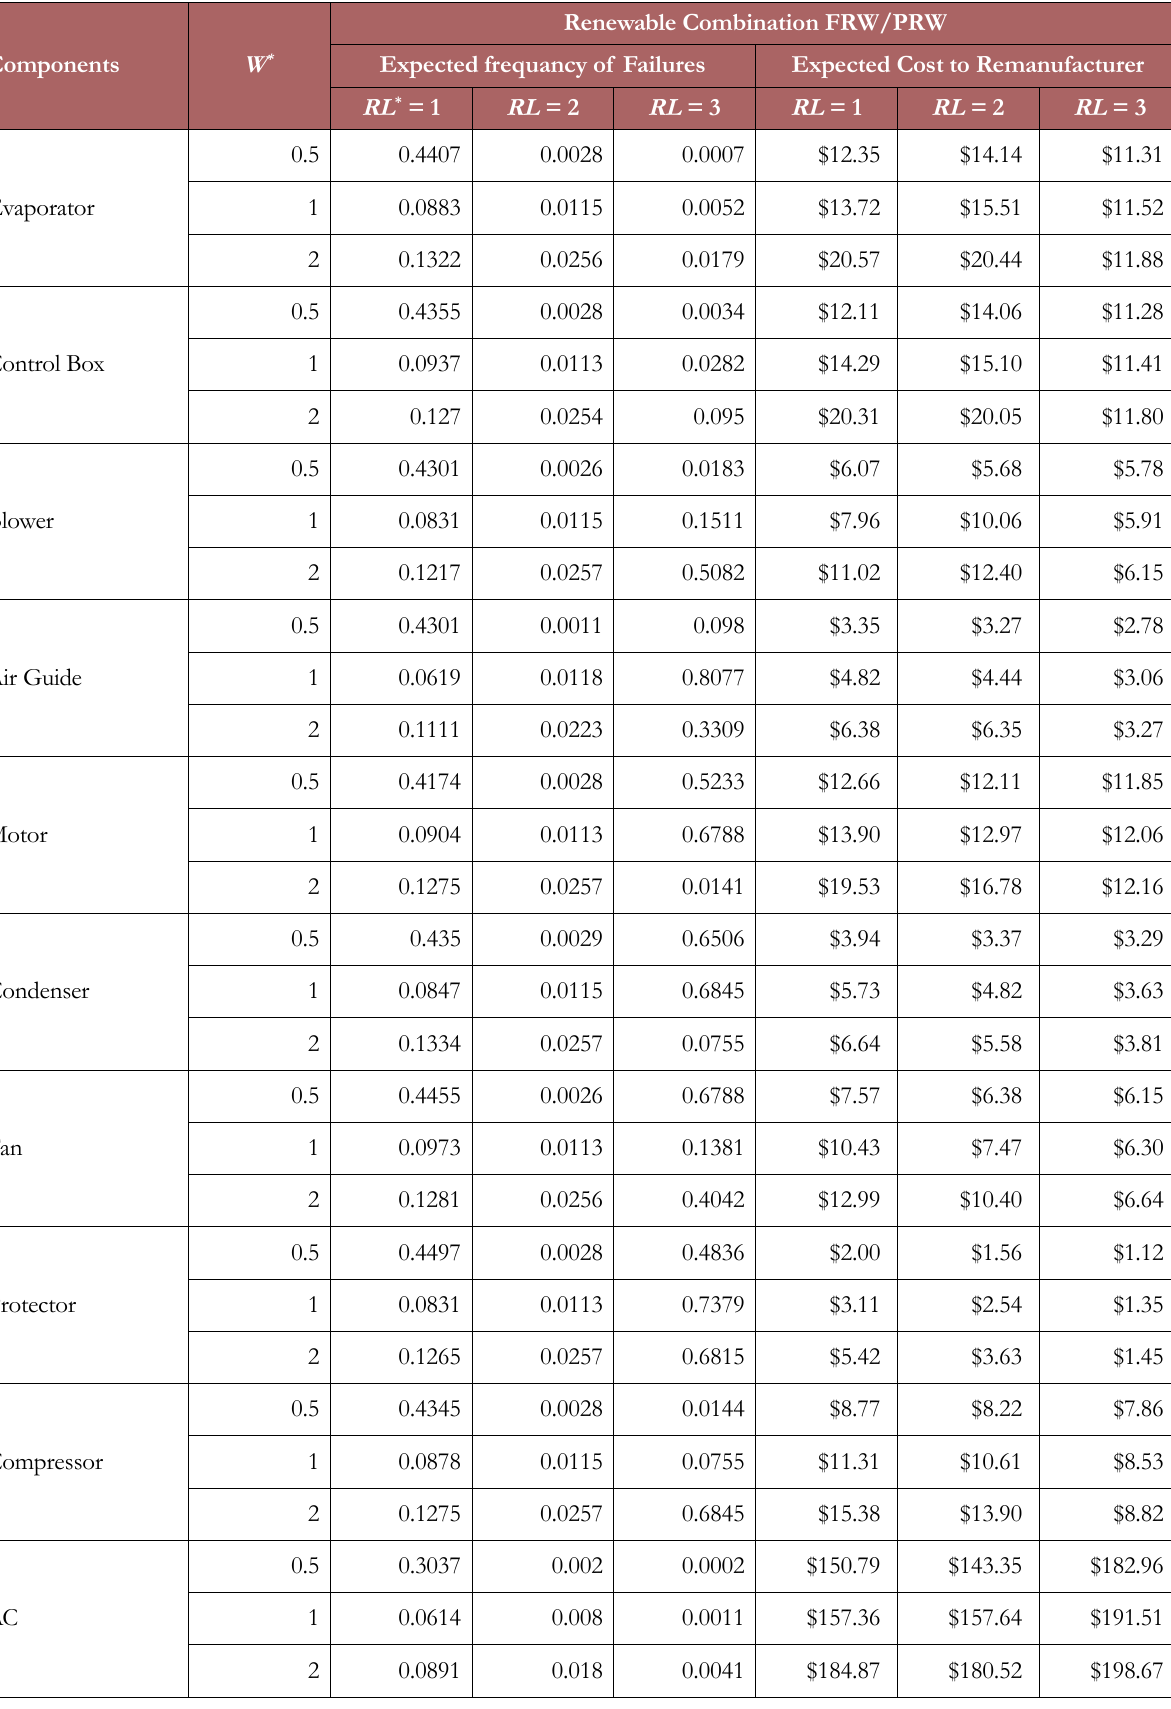
Table 4. Expected number of failures and cost for remanufactured AC and components for 2D Renewable FRW, PRW and Combination